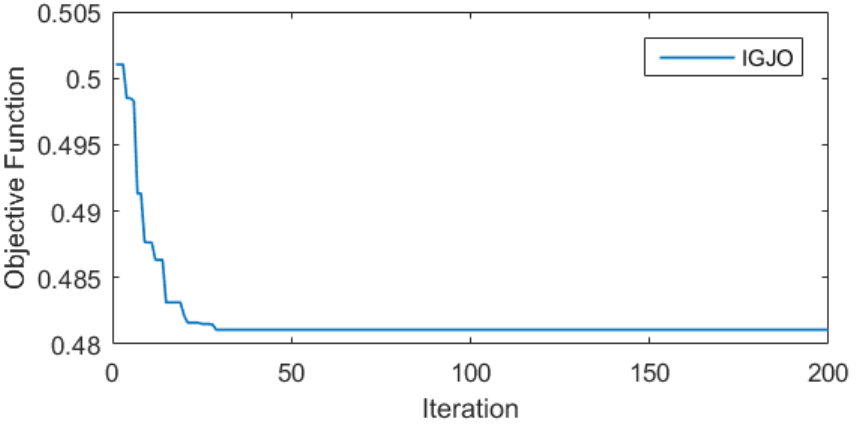
Figure 11. Convergence process of IGJO in allocation and scheduling of WT and PHEVs in the distribution network considering battery degradation cost.